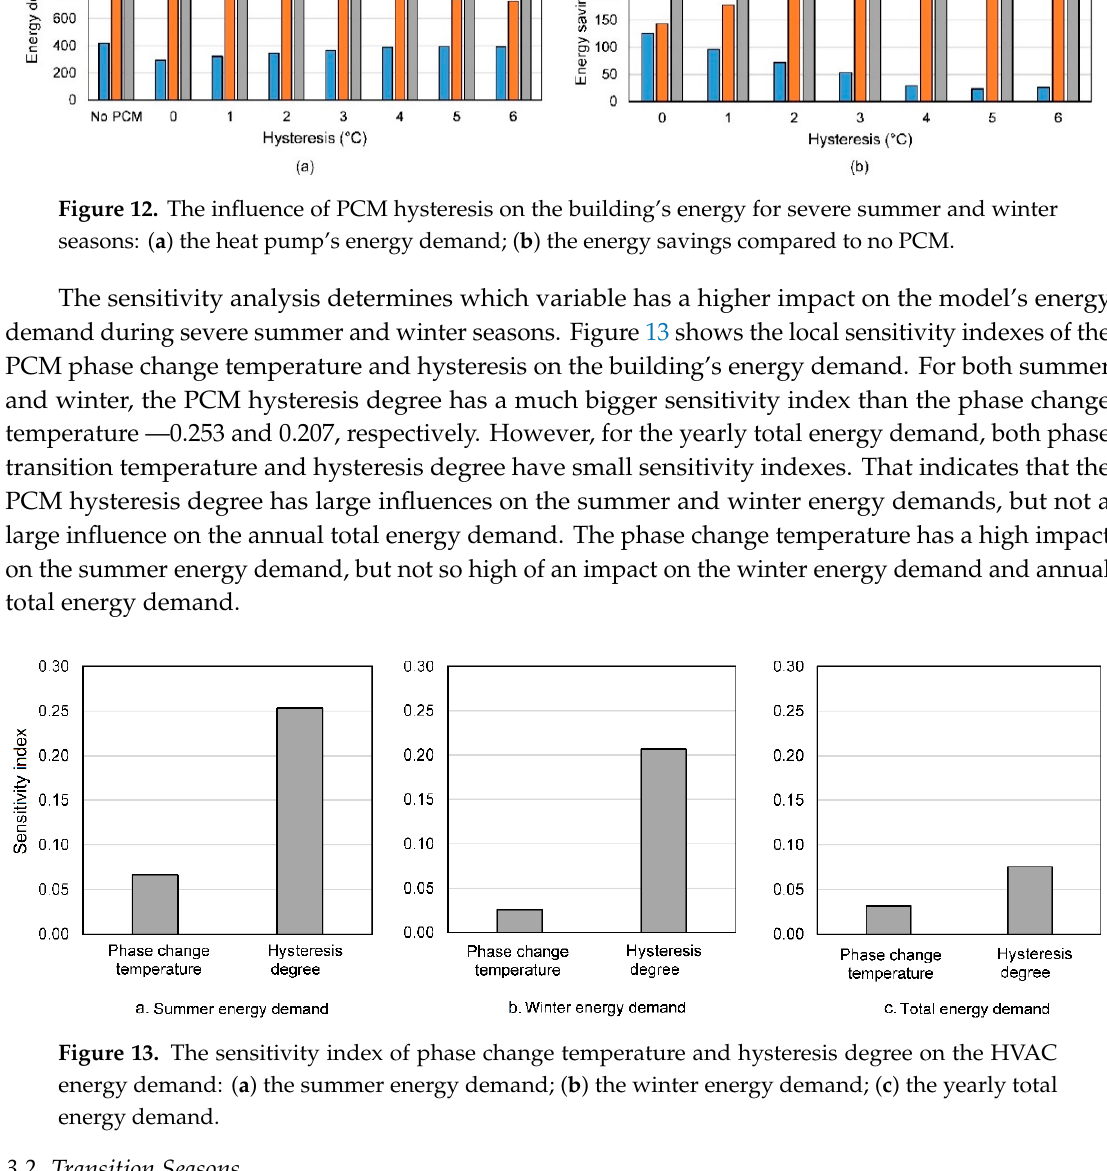
Figure 14. The predicted percentage of dissatisfied (PPD) of the models with different PCM phase change temperatures in transition seasons. Similarly, the influence of the PCM hysteresis on the PPD is shown in Figure 15. Compared to the model without PCM, the models with PCM all have lower PPD. For the summer transition season, the PPD increases along with the increase of the PCM hysteresis. For the winter transition season, the PPD decreases along with the increase of the PCM hysteresis degree. Consequently, the average PPD during the transition season remains the same along with the increase of the PCM hysteresis degree.